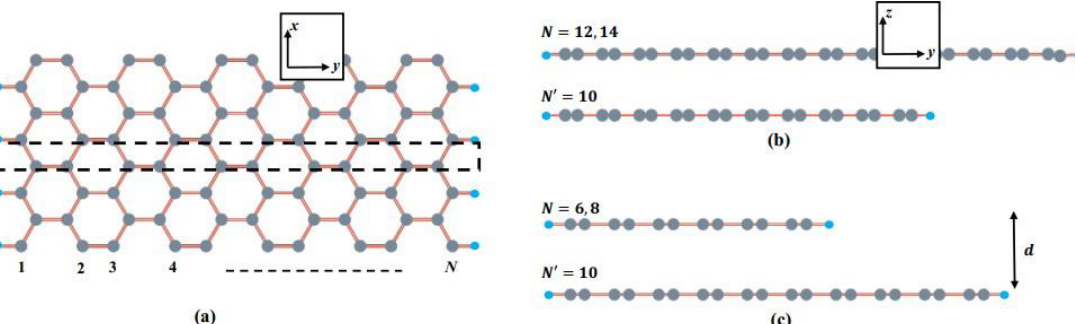
Fig. 1. Crystal structure of AA-stacked bilayer ZGNR from top view (a) and side view (b, c). Here, the dashed square and d are addressed to the unit cell and thickness